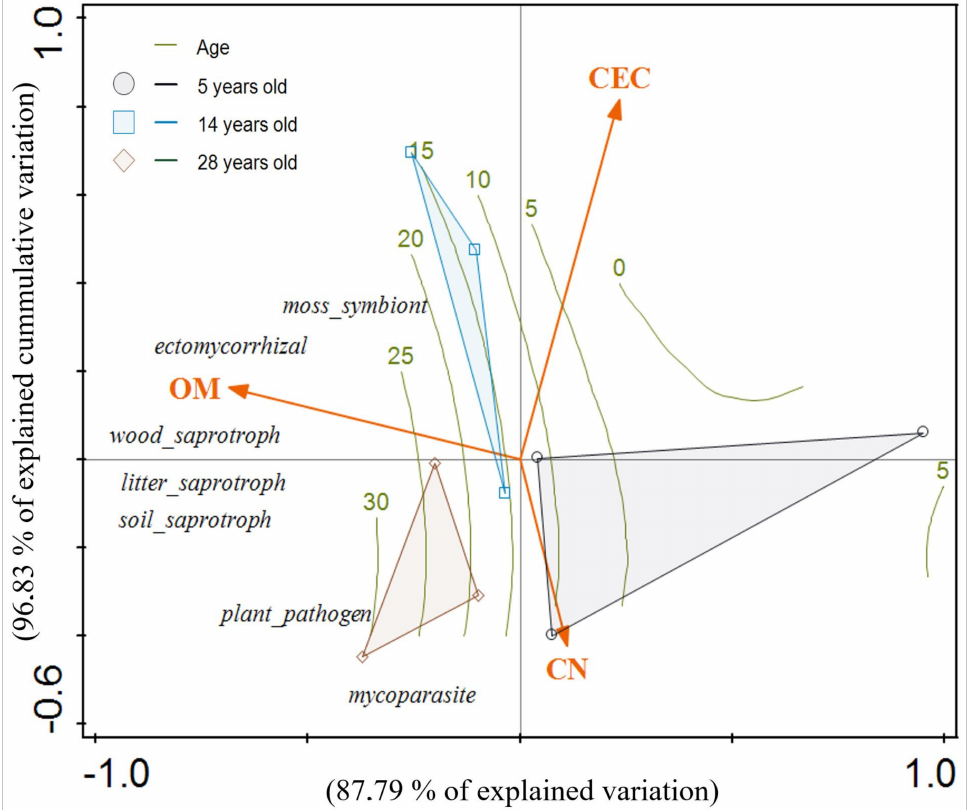
Figure 6. Canonical correspondence analysis ordination plot based on abundance data of functional fungal groups observed in young (5 years old), medium-aged (14 years old), and mature (28 years old) Pinus radiata stands in Menagesha Suba, central Showa, Oromia National Regional State, Ethiopia. Plots depicted in the same color are in the same stand. Edaphic variables are shown in orange. The percentage of cumulative explained variation by each axis is shown. Isolines indicate the stand age values (R 2 =